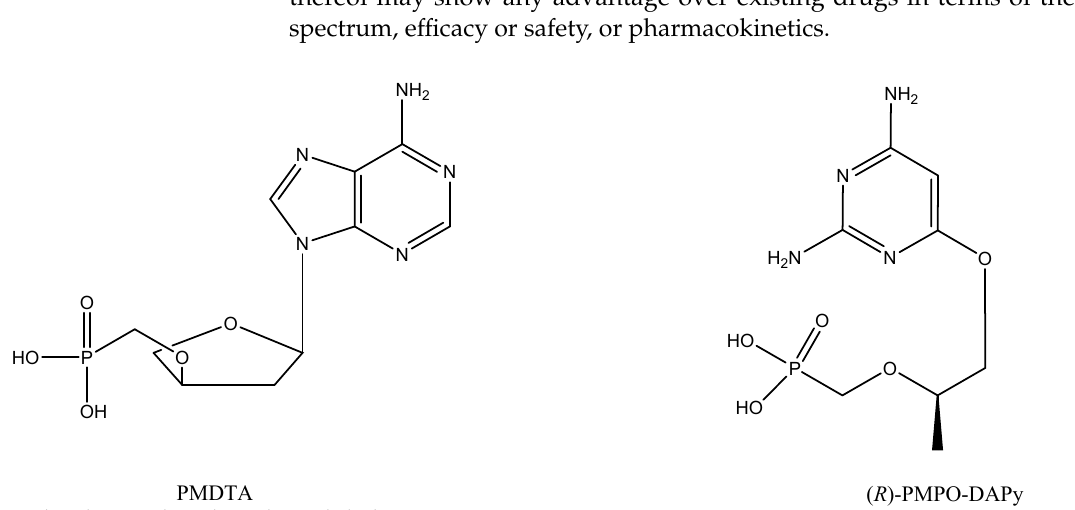
Figure 5. Examples of tenofovir (( R )-PMPA) derivatives in the pipeline (not (yet) developed clinically), as potential HIV and/or HBV inhibitors.